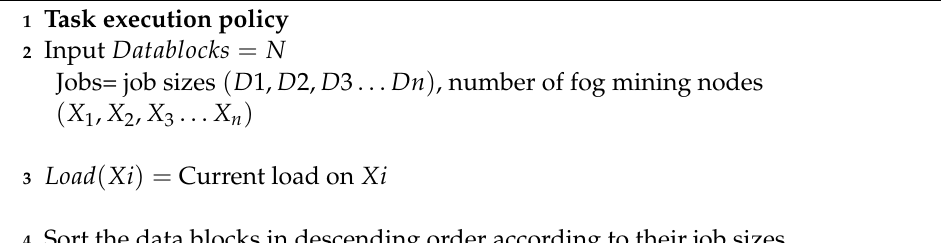
Algorithm 1: Proposed algorithm for load balancing